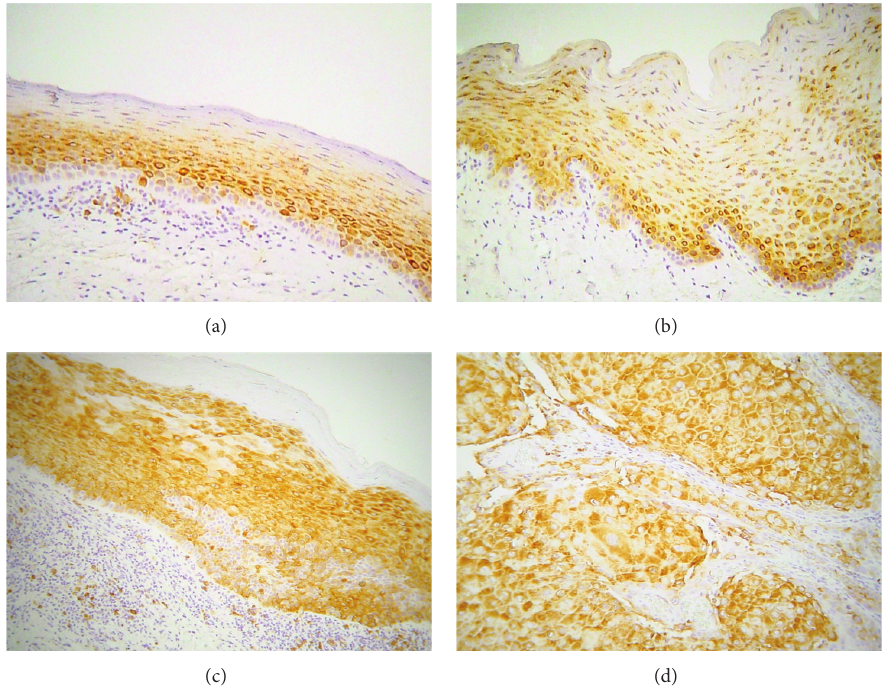
Figure 6: Immunohistochemical expression of phosphorylated ribosomal protein pS6 (phospho-pS6) in selected cases of (a) oral lichen planus (OLP), (b) normal mucosa (NM), (c) oral leukoplakia (OL), and (d) oral squamous cell carcinoma (OSCC) (immunohistochemistry, 100x